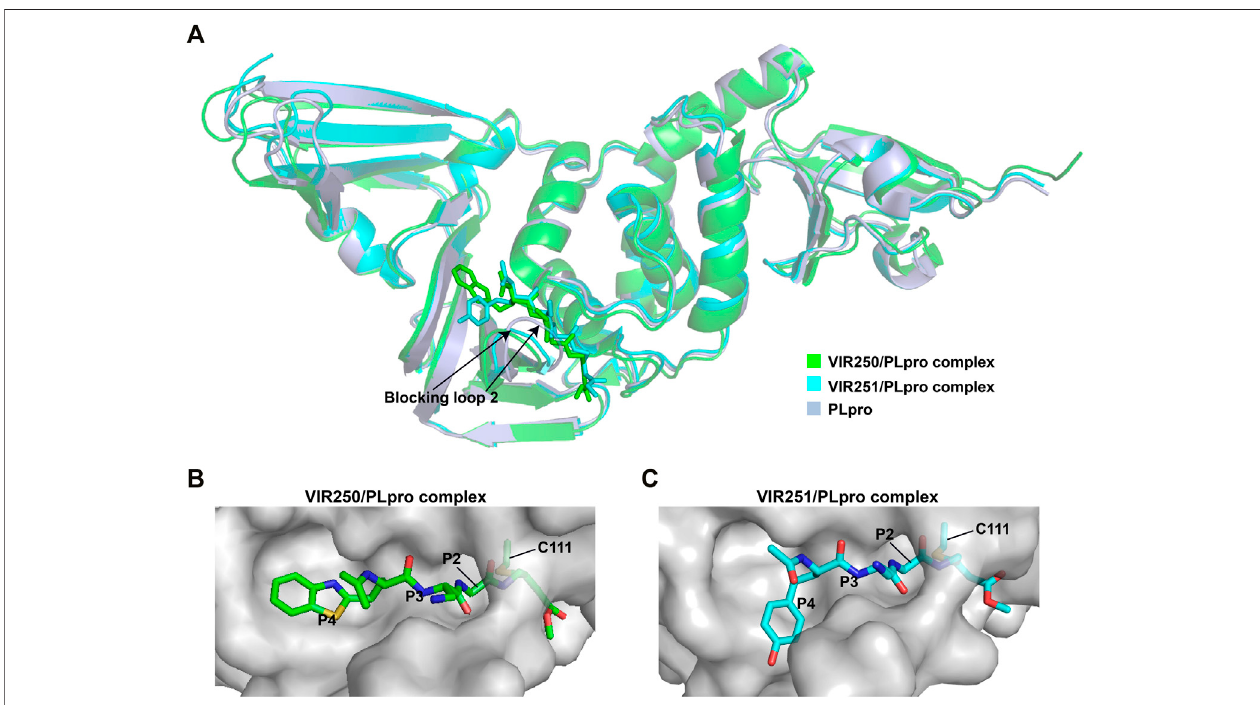
FIGURE4 | Crystal structures ofSARS-CoV-2PLpro in complex withcovalentinhibitors. (A) Superpositionof SARS-CoV-2 PLpro (light blue; PDB ID: 6WZU) with VIR250/PLpro(green;PDBID:6WUU)andVIR251/PLpro(cyan;PDBID:6WX4)complexes.Theblockingloop2isindicated. (B) SurfacepresentationofVIR250binding pocket. PLpro is shown as gray surface, while VIR250 is shown as sticks. The catalytic cysteine of PLpro forms a covalent bond with VIR250. The P2-P4 positions are labeled. (C) SurfacepresentationofVIR251bindingpocket.PLproisshownasgraysurface,whileVIR251isshownassticks.ThecatalyticcysteineofPLproforms a covalent bond with VIR251. The P2-P4 positions are